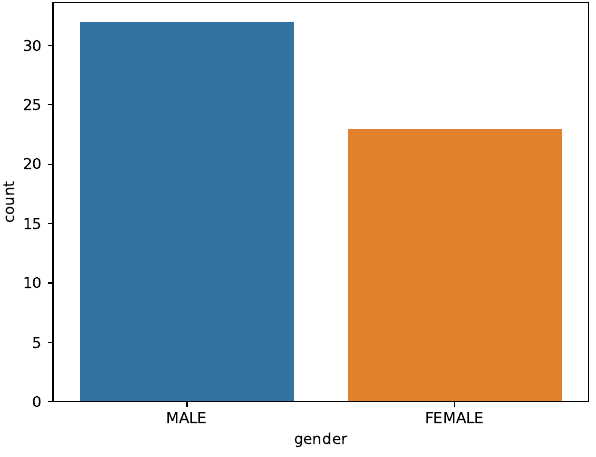
Figure 4. Statistics of Student